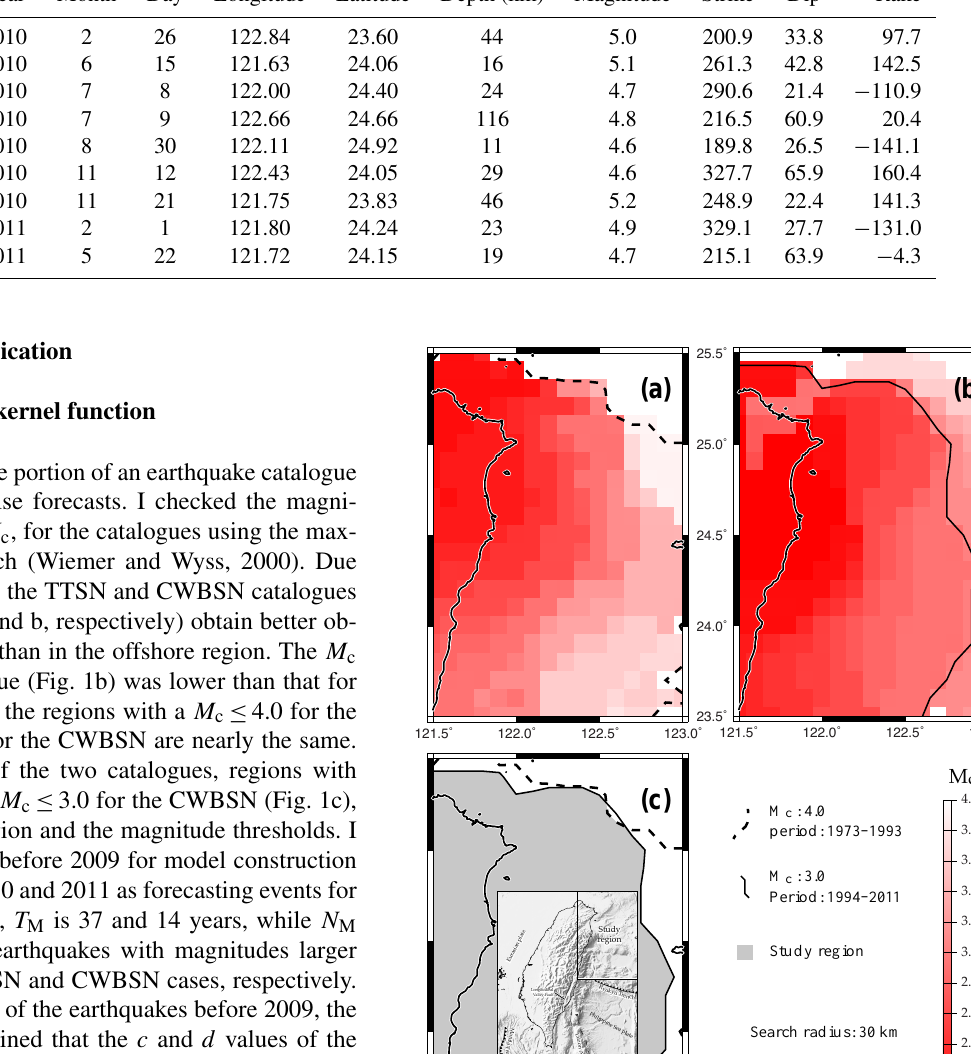
Table 1. Source parameters for the source events used for the inputs of the rate-and-state friction model. Earthquakes with M w ≥ 4.5 that occurred in 2010 and 2011 were considered. Parameters were determined based on the Broadband Array in Taiwan for Seismology (BATS). No. of event Year Month Day Longitude Latitude Depth (km) Magnitude Strike Dip Rake